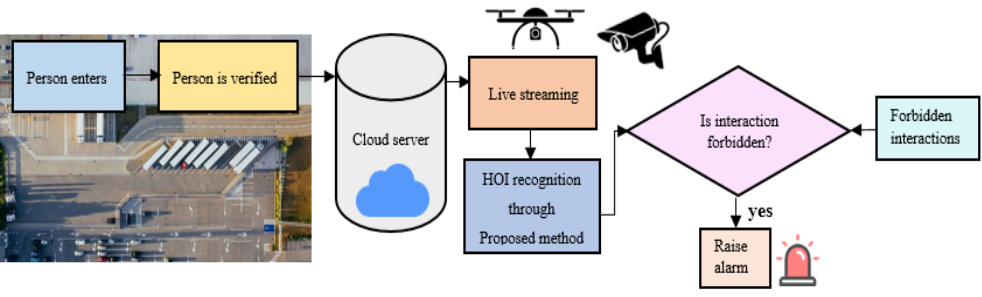
Figure 21. An example of practical usage of the proposed HOI recognition system for surveillance.